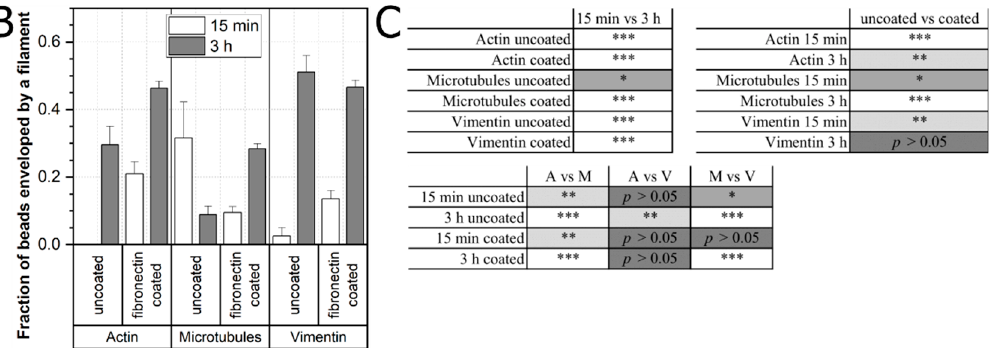
Figure 1. Latex beads cause the cytoskeleton rearrangement. MEF cells were plated on glass-bottom dishes and incubated with 2 µm diameter latex beads (coated with fibronectin and uncoated) for 15 min or 3 h, then fixed, stained for cytoskeletal components (separately) and visualized using confocal microscopy in 3D. Images are presented as sums of stacks. ( A ) Representative images of cytoskeletal structures in experiments with fibronectin-coated beads are shown, arrows point at spots where beads were enveloped by the cytoskeleton and visible changes could be observed. ( B ) Histogram showing the fraction of beads enveloped by a specific component of the cytoskeleton. Fully enveloped beads were counted and presented as a fraction of all beads interacting with cells. Data are presented as a percentage fraction ± SEM (actin, 15 min, uncoated, n = 16; actin, 3 h, uncoated, n = 71; actin, 15 min, coated, n = 129; actin, 3 h, coated, n = 523; microtubules, 15 min, uncoated, n = 19; microtubules, 3 h, uncoated, n = 135; microtubules, 15 min, coated, n = 285; microtubules, 3 h, coated, n = 905; vimentin, 15 min, uncoated, n = 39; vimentin, 3 h, uncoated, n = 100; vimentin, 15 min, coated, n = 192; vimentin, 3 h, coated, n = 581). ( C ) Two proportion Z-test was used to determine statistical significances between specific samples: ( upper left ) bead incubation duration: 15 min versus 3 h; ( upper right ) uncoated versus coated beads; ( lower left ) comparison between cytoskeletal components: (A)ctin, (M)icrotubules, and (V)imentin. * p < 0.05, ** p < 0.005, *** p < 0.001. Data are representative of at least two independent experiments.